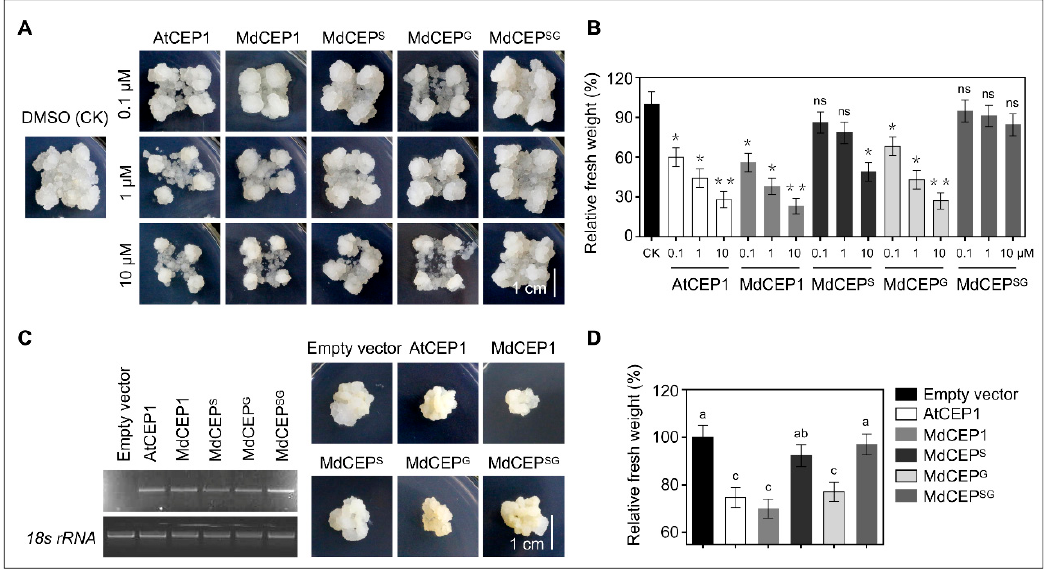
Figure 7. MdCEP overexpression leads to a retarded growth in apple callus. ( A ) Ten-day-old apple callus with similar size were cultured on different concentrations of CEPs (AtCEP1, MdCEP1 and